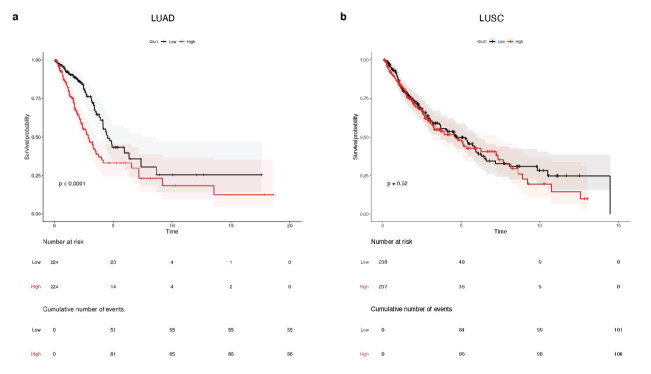
Survival analysis of 448 lung adenocarcinoma patients (TCGA-LUAD) and 475 lung squamous cell carcinoma patients (TCGA-LUSC).Median glucose transporter GLUT1 expression value splits down the patient tumors into low and high GLUT1 expressers. Kaplan-Meier plots show that GLUT1 expression is associated with a poor overall survival in patients with (a) LUAD tumors, whereas it is not prognostic in patients with (b) LUSC lesions. p-values were computed with Wald test.